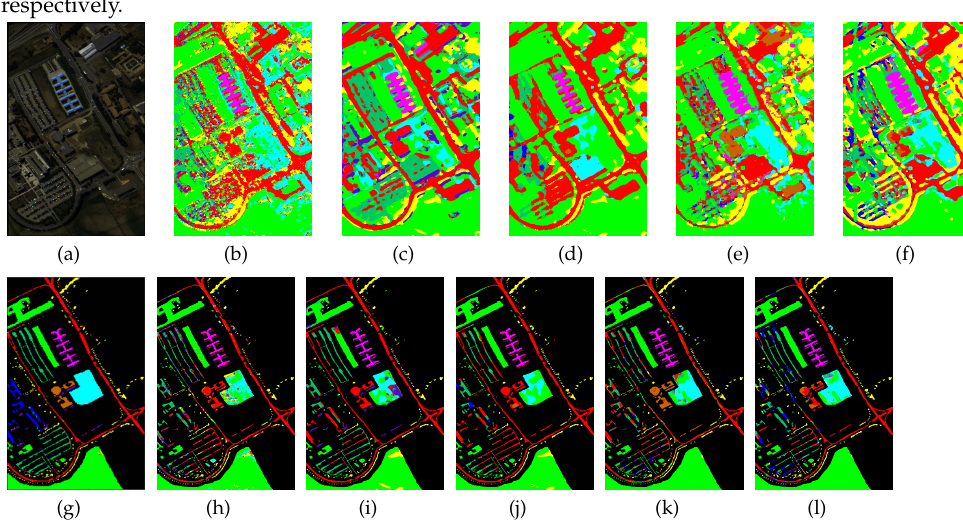
Figure 6. Classification maps generated by all of the competing methods on the University of Pavia data with 0.1% training samples. ( a , g ) are false-color images and ground-truth maps, respectively, while ( b – f ) and ( h – l ) are the results of HybridSN, SSRN, A-SPN, MCNN-CP, and Oct-MCNN-HS,